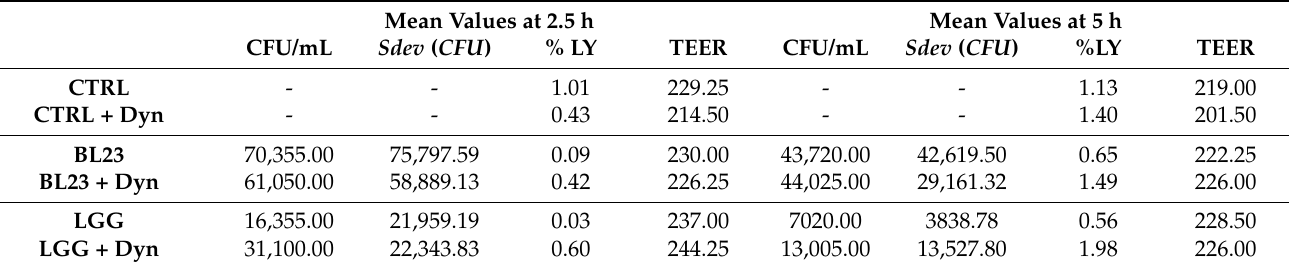
Table 1. Transcytosis determined in transwells. This table shows colony forming units found in the basolateral compartment after incubation of Caco-2 monolayers where BL23 and LGG at MOI 10 3 had been inoculated at the apical compartment and incubated for the indicated time with or without 80 µ g/mL Dynasore, as well as Lucifer Yellow (50 µ mol/L) to control paracellular diffusion. TEER values shown are the mean determined the day of the experiment for each insert. There were no significant differences between the means ( t test). Mean Values at 2.5 h Mean Values at 5